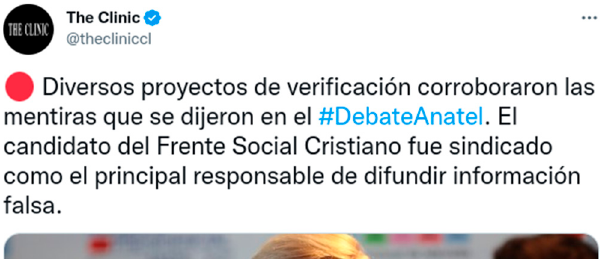
Figure 7. Exemplary case in Isntagram